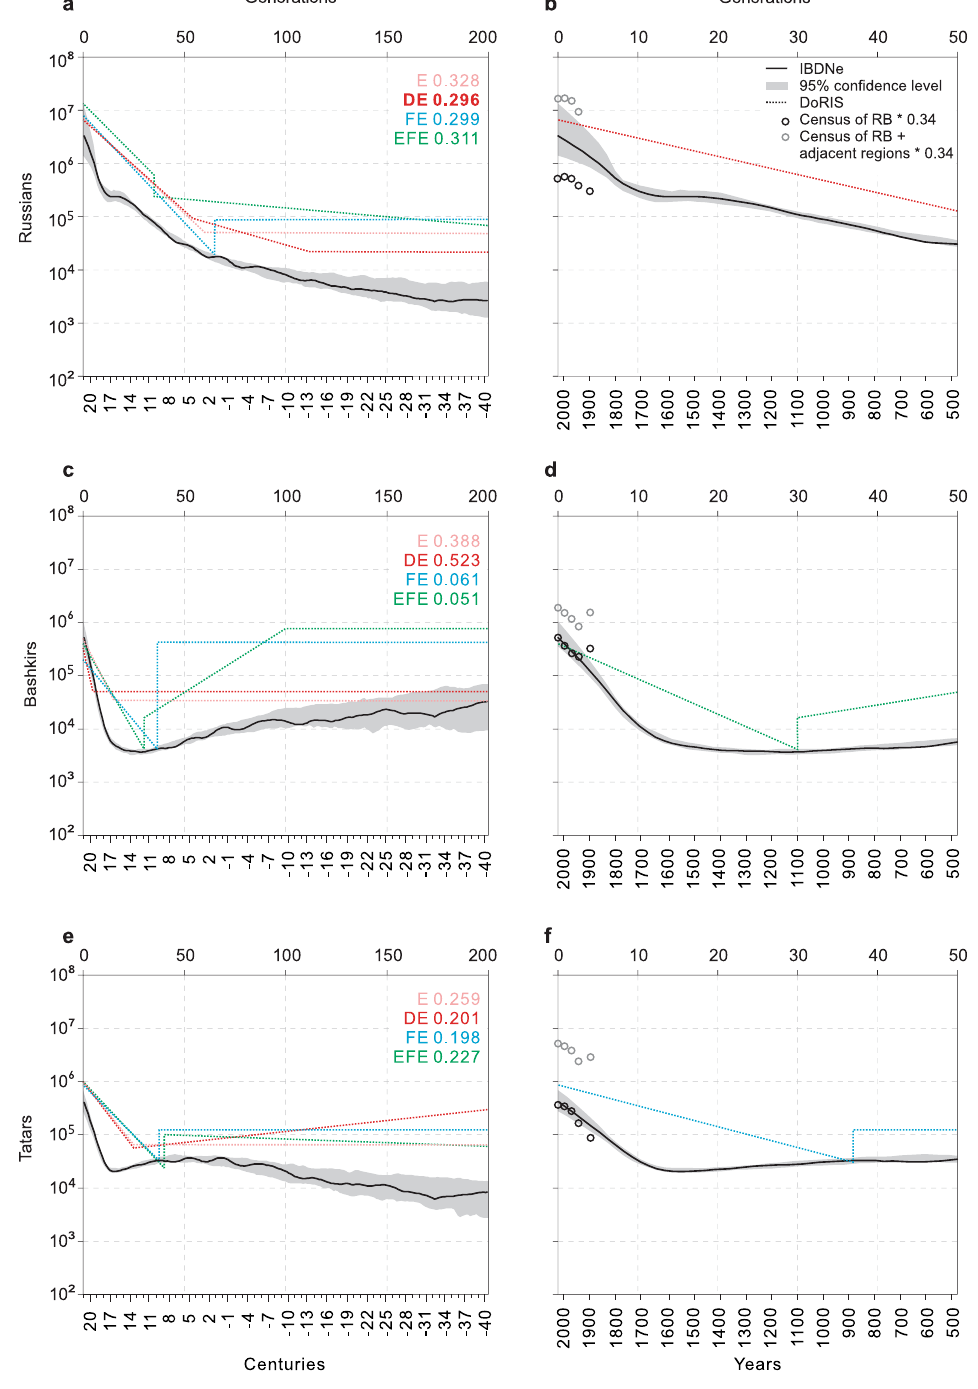
Figure 3. The recent effective population size of the ethnic groups of the UFA cohort. The left panel shows the estimated population size trajectories for the past 200 generations, and the right panel shows the more detailed zoomed-in trajectories for the past 50 generations (assuming 30 years per generation). DoRIS demographic scenarios: (E) exponential expansion (or contraction); (DE) double exponential expansion; (FE) founder event followed by exponential expansion; (EFE) expansion (or contraction) followed by founder event, then exponential expansion. Each scenario is accompanied by the corresponding optimal RMSE. The right panels show the census of the RB (black circles) and the census size of the RB + adjacent regions (grey